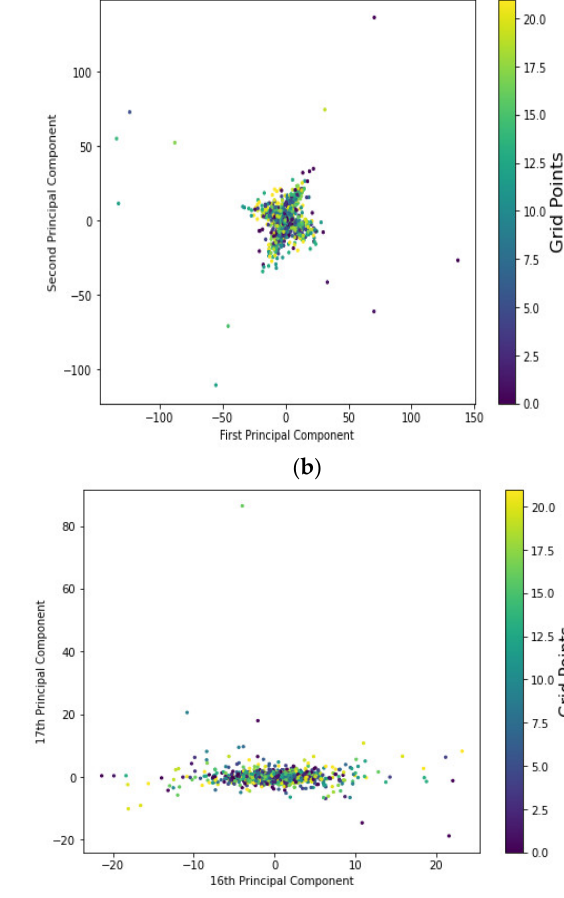
Figure 6. Distribution of principal components of datasets collected during month 1 with their cor- responding RPs.